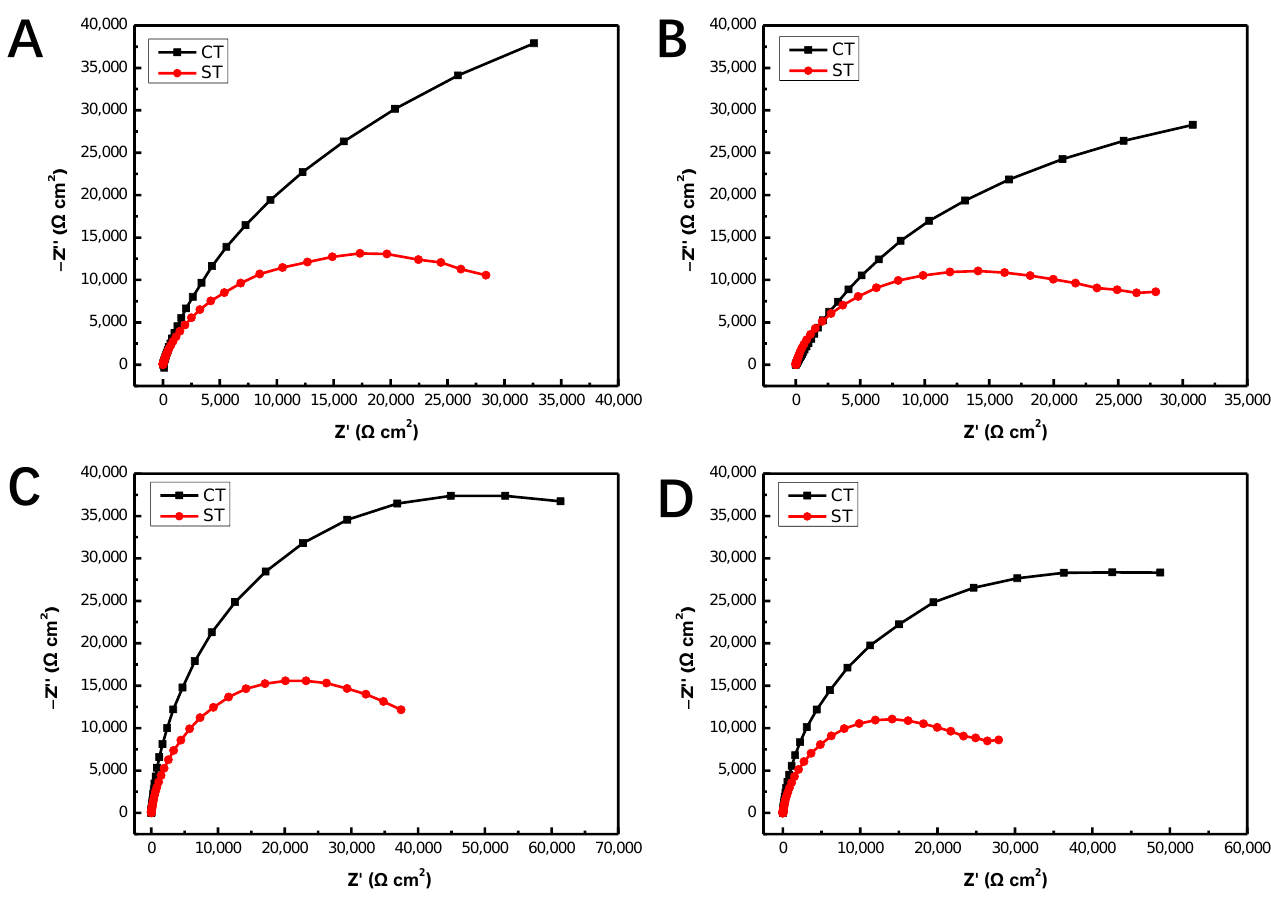
Figure 4. Nyquist plots for ST and CT in ( A ) 3.5 wt.% NaCl solution, ( B ) 15 wt.% NaCl solution, ( C ) PBS buffer solution and ( D ) SBF solution.